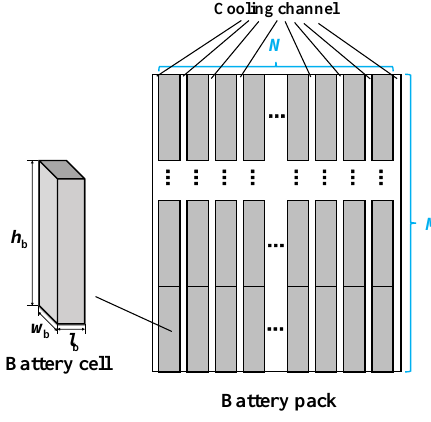
Figure 1. Schematic of the battery